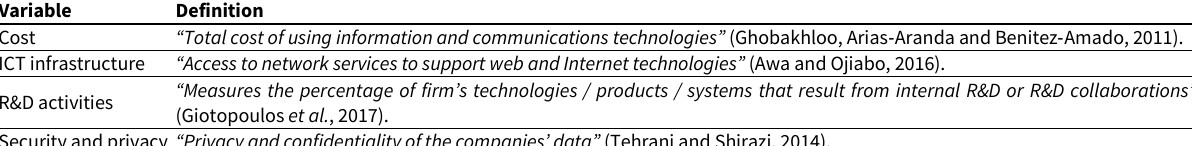
Table 2. Technological variables that describes IoT adoption in SMEs